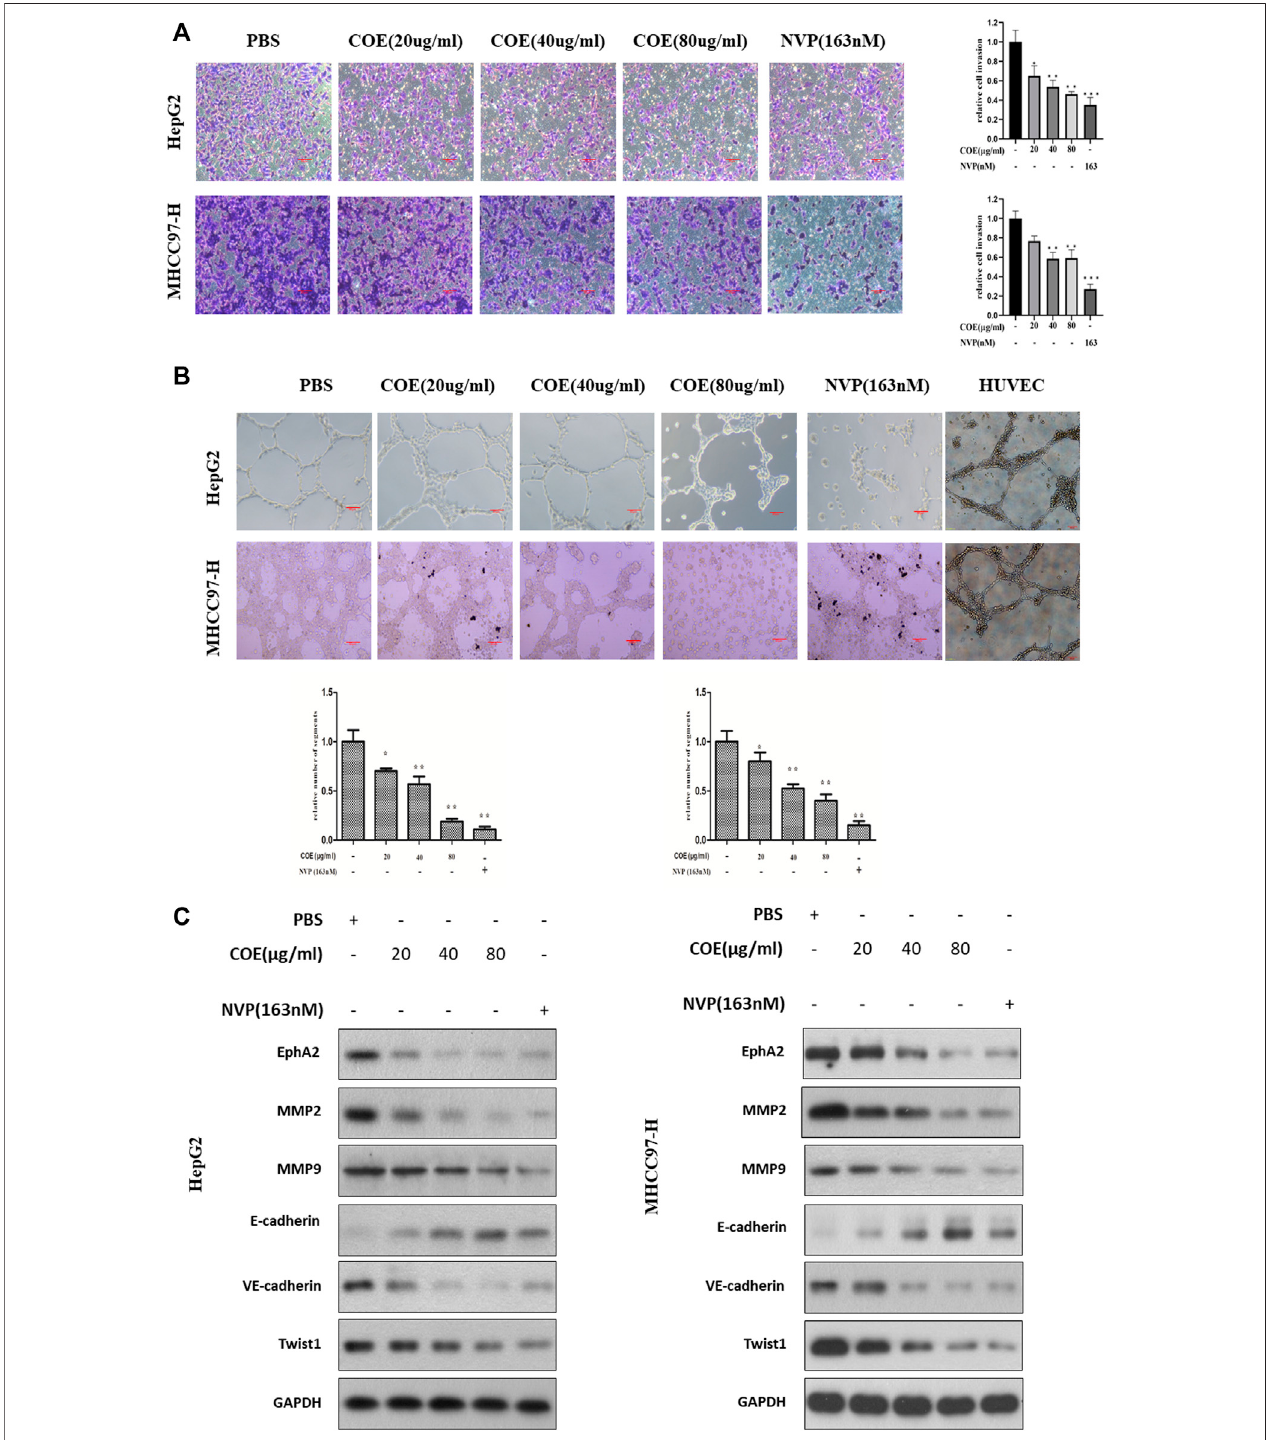
FIGURE 6 | COE inhibits invasion and VM associated protein biomarkers via inhibiting EphA2 in HCC cells. (A) , COE decreases HepG2 and MHCC97-H cell invasion. Left: representativeimagefortranswellassay, right: histogramofinvadedcells. × 200,20 µm. (B) ,COEandNVPinhibitVMformationofHepG2andMHCC97- H on matrigel. HUVECs used as the control. (C) , Western blot analysis on the change of expression of VM related proteins after COE treatment.